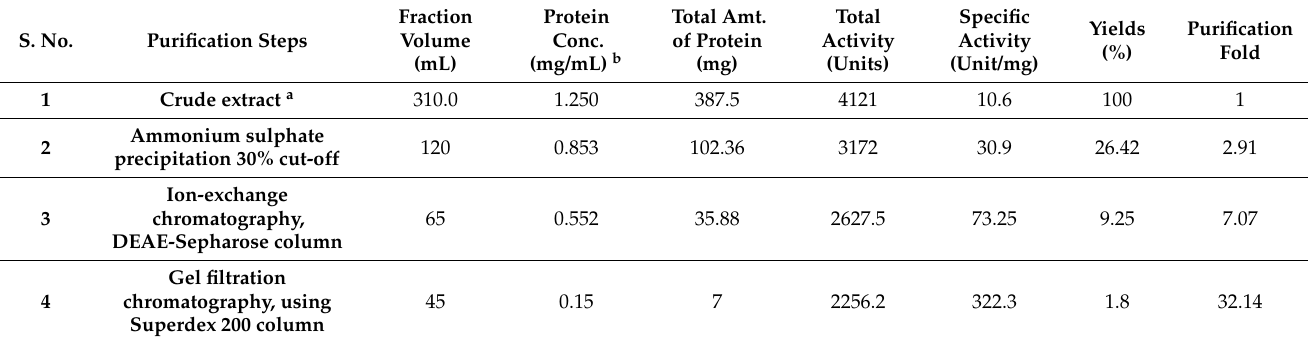
Table 1. Purification summary of tyrosinase.